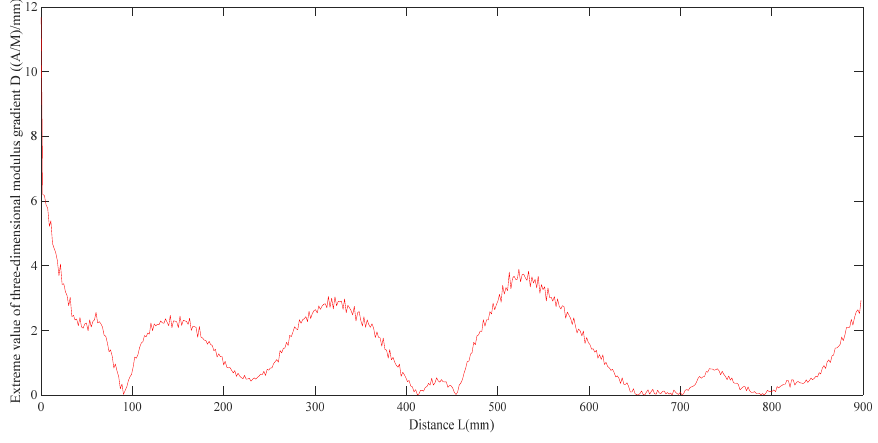
Figure 13. Extreme value of three-dimensional modulus gradient of welding defects.